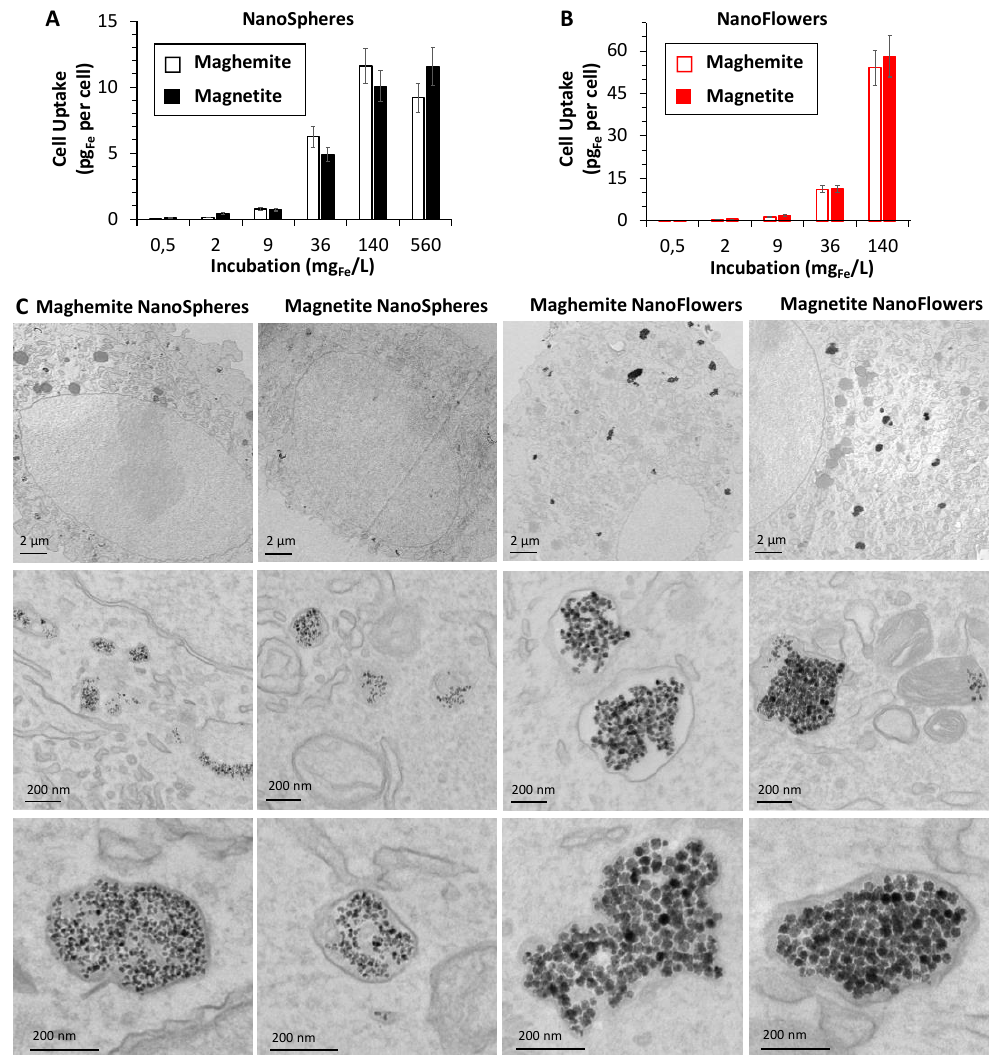
Figure 4. Study of MNPs internalization in vitro inside tumor cells. Chart of the intracellular Fe amounts for nanospheres ( A ) and nanoflowers ( B ) incubated with PC3 prostate cancer cells in their maghemite (empty columns) and magnetite (full columns) forms, at di ff erent doses of given extracellular Fe concentrations from 0.5 to 560 mg Fe / L. TEM images showing the intracellular MNP deposits for the four di ff erent preparations ( C ) at lower (upper row) and higher magnification (medium row), incubated 30 min at 36 mg Fe / L; in particular, all the nanoparticles are found exclusively within the endosomal compartments (bottom row).